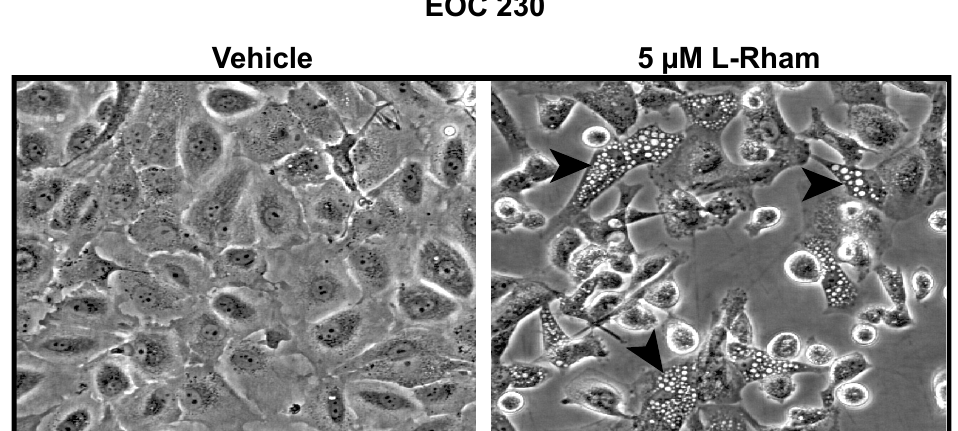
Figure 6. L -Rham phenotypic response. Development of phase-lucent cytoplasmic vesicles (arrow- heads) 24 h after initial exposure to L -Rham. Primary EOC230 cells were isolated from HGSOC patient ascites. Vehicle = 0.9% saline. Solid bar = 100 µm.